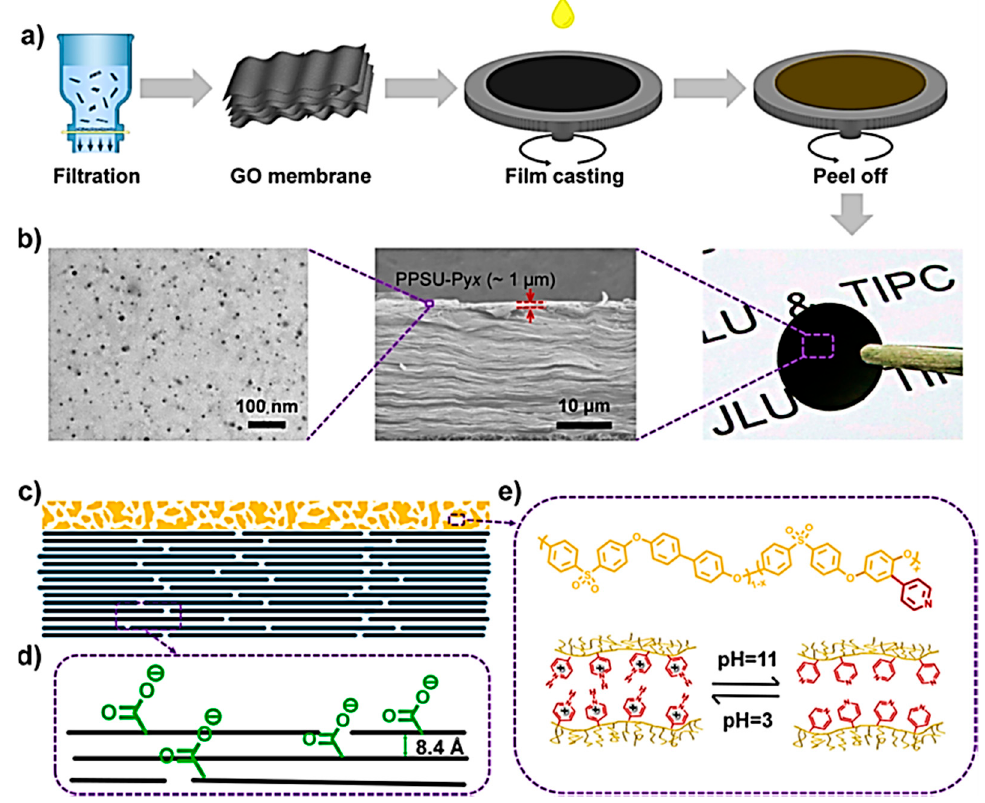
Figure 7. Schematic of heterogeneous membrane with asymmetric structure ( a ) fabrication process of membrane: copolymer spin-coated on GO nanosheets prepared by vacuum filtration; ( b ) transmission electron microscopy image of PPSU-Pyx that was marked with phosphotungstic acid (PTA); middle image is scanning electron microscopy observation of cross section of heterogeneous membrane; on right is photo of heterogeneous GO/PPSU-Pyx membrane; ( c ) schematic of heterogeneous structure with 3D pores (self-assembly into interconnected pores by ionomers) and 2D pores (self-assembly into nanosheets by GO); ( d ) illustration of GO nanosheets with spacing of ca. 0.84 nm; and ( e ) chemical structure of PPSSU-Pyx (upper) and configuration change of polymer in response to pH (lower) [108]. PPSSU-Pyx = polyphenylsulfone-pyridine; GO/PPSU-Pyx = graphene oxide/poly- phenylsulfone-pyridine; GO = graphene oxide. Reproduced with permission from ACS.